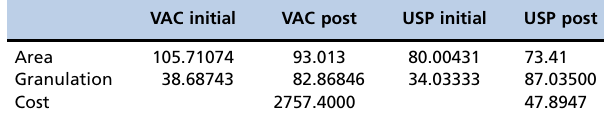
Table 3 - Comparative cost of dressings